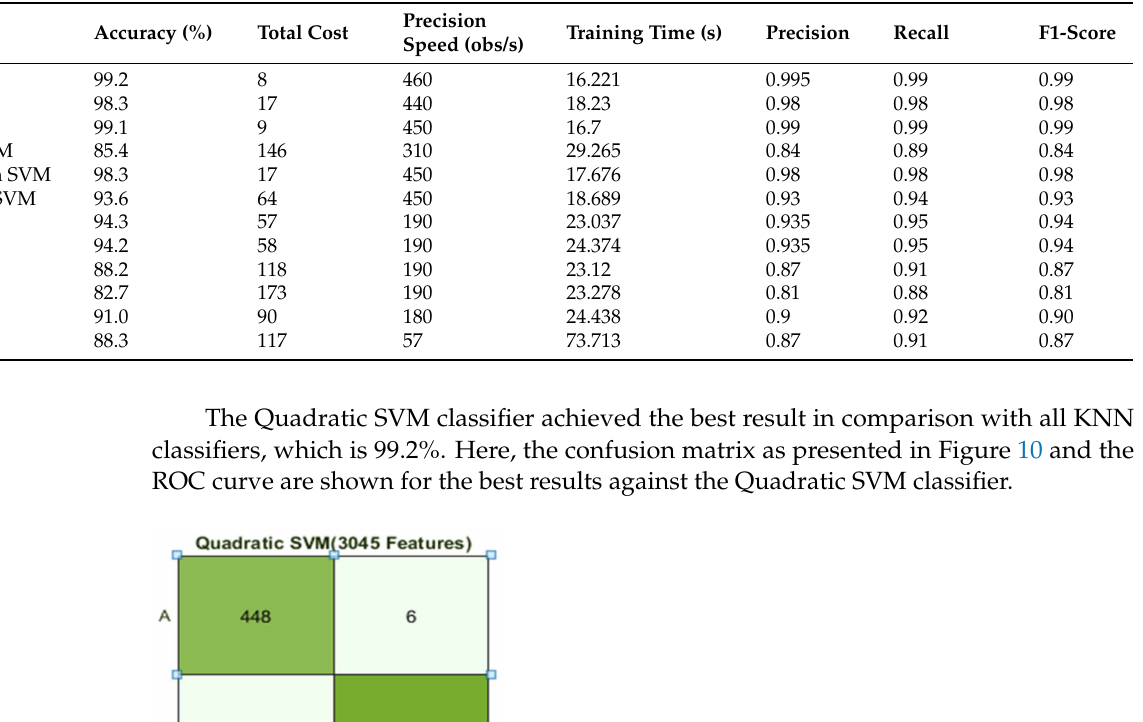
Table 5. Experiment_1 using 10 Folds (3045 Feature).